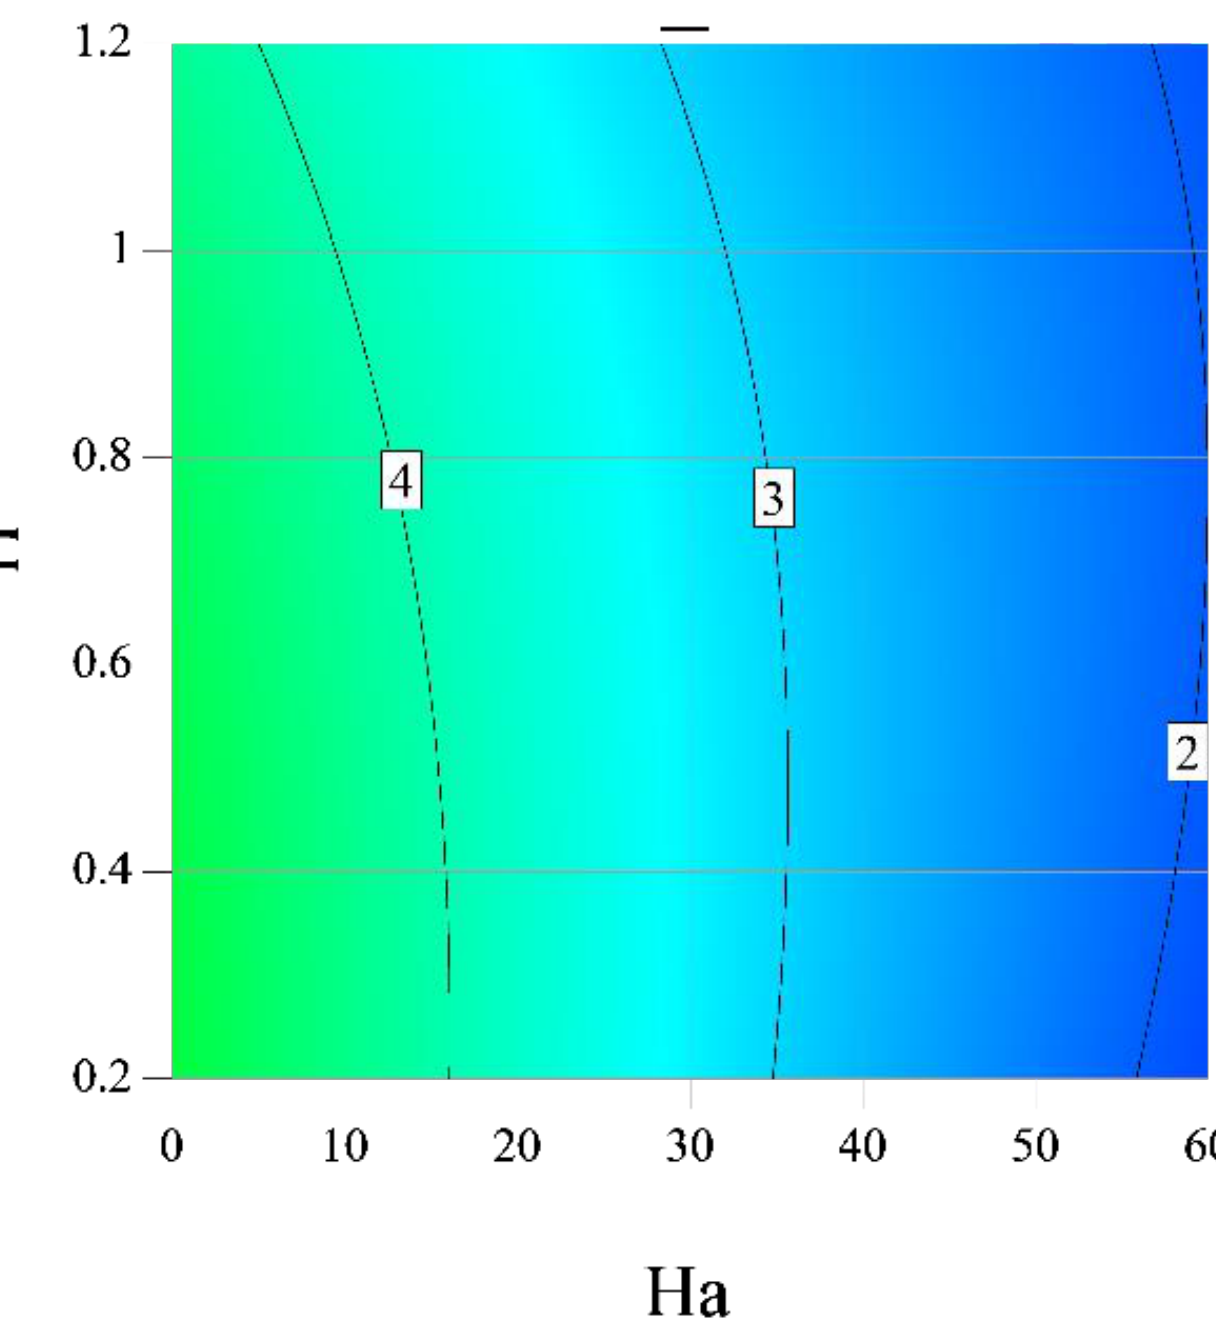
Figure 10. EGN for different Ha and various blade lengths when Ra = 10 5 , W = 0.7, and the volume fraction is 0.3%. N-Ps at Ra = 10 5 , Ha = 0, and W = H = 0.2. It is observed that an increment in the amount